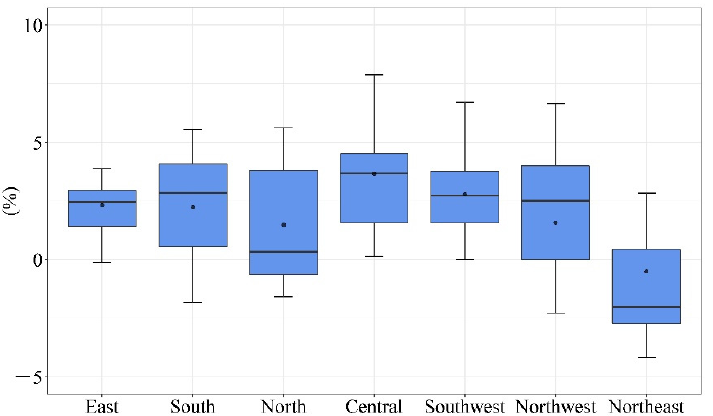
Figure 4. The value of the change in population agglomeration degree of the county seat in the seven regions during 2020–2021 (Source: by the authors).